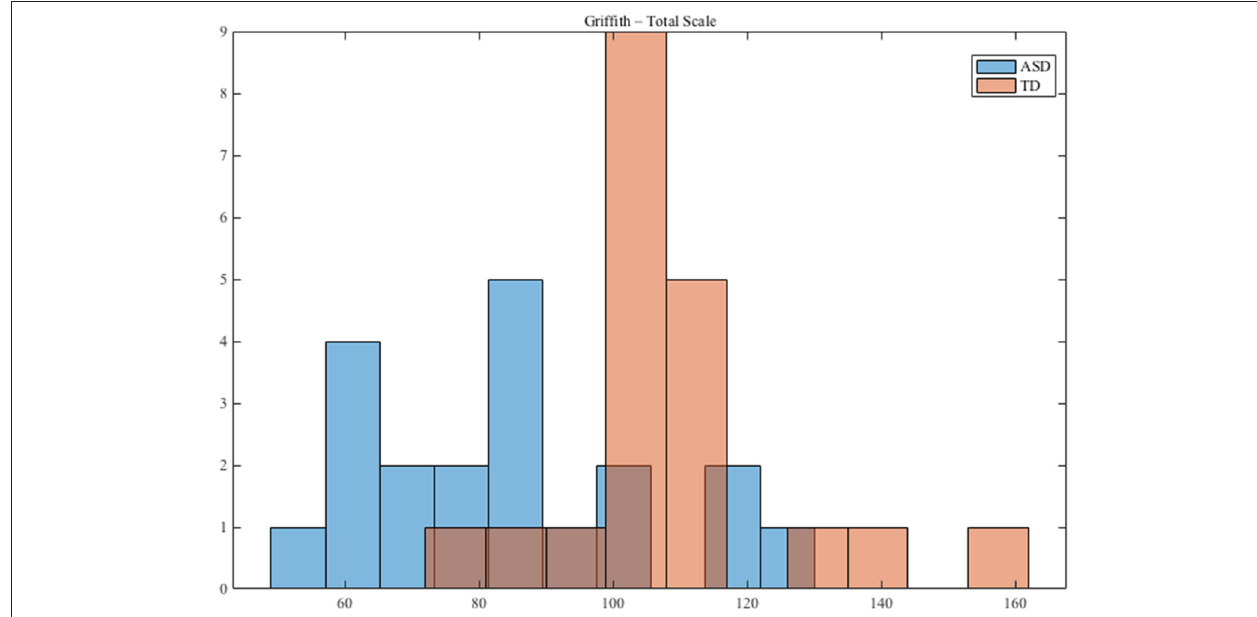
FIGURE 1 | Distribution of Griffith Performance for ASD and TD groups.